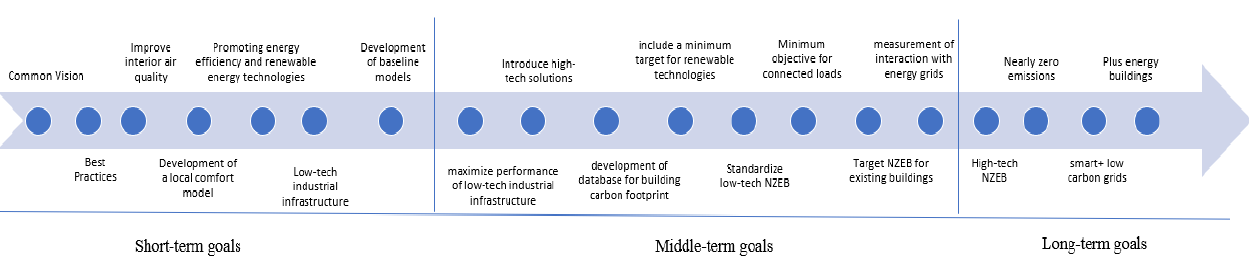
Figure 2. Non-industrial countries roadmap [1].